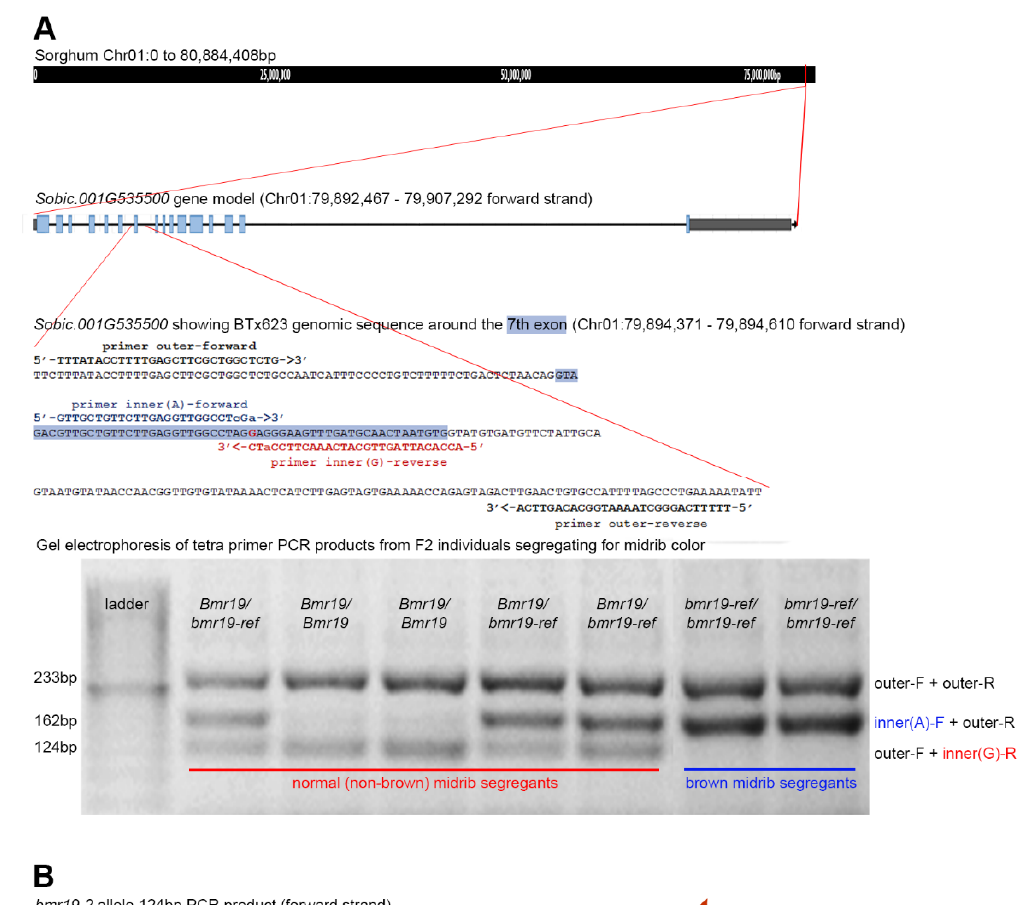
Figure 4. Detection of alleles at Bmr19 using DNA based markers. ( A ) Location and scheme for the primer set used to detect the SNP distinguishing the bmr19-ref (A) from wildtype Bmr19 (G) alleles. Based on the method described by Medrano and de Oliveira (2014) [37], four primers in the PCR amplify three possible products. The outer primers (outer-F + outer-R) result in a control amplicon of 233 bp in all samples. Mismatches are introduced near the 3 (cid:48) ends of both inner primers (small case) which both end on the SNP. In the PCR with a wildtype template allele ( Bmr19 ), only the inner(G)-R primer works to give a second amplicon of 124 bp with outer-F since the second mismatch at the 3 (cid:48) end of inner(A)-F is not tolerated. Only when there is an “A” at this position, as occurs in bmr19-ref , will the inner(A)-F give an amplicon with outer-R of 162 bp. Because of the double mismatch at the 3 (cid:48) end, inner(G)-R does not work with the mutant template. The PCR products are separated by size with gel electrophoresis. In F 2 populations derived from bmr19 crossed with wildtype that segregate for midrib phenotypes, all brown midrib individuals give two bands (233 + 162 bp) corresponding to the bmr19-ref / bmr19-ref genotype. Normal plants give either two bands (233 + 124 bp) if they are homozygous ( Bmr19 / Bmr19 ) or three bands (233 + 162 + 124 bp) if they are heterozygous ( Bmr19 / bmr19-ref ). ( B ) Due to the proximity of the SNP distinguishing the bmr19-2 allele, the same tetra primer set was useful for confirming F 1 s from the allelism test cross of emasculated bmr19 with 2354. PCR products from true F 1 s ( bmr19-ref / bmr19-2 ) give three bands like the heterozygotes pictured above while any selfs due to incomplete emasculation ( bmr19-ref / bmr19-ref ) give only two bands. Sequencing of the smallest band (124 bp) from F 1 plants showed the bmr19-2 mutation G → A at the position indicated in orange. The genotype bmr19-ref / bmr19-2 had a brown midrib phenotype, confirming that the mutations are